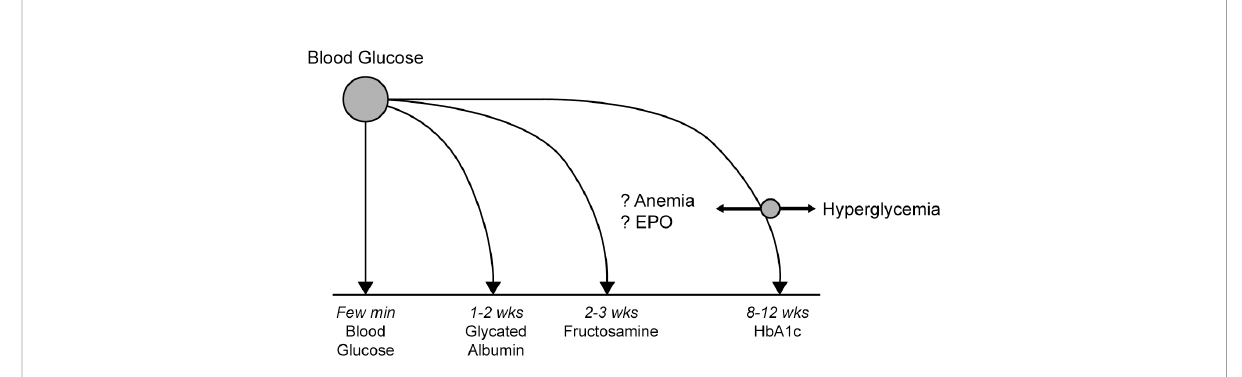
FIGURE 1 Measures for assessing glycemic control in ESKD patients with diabetes